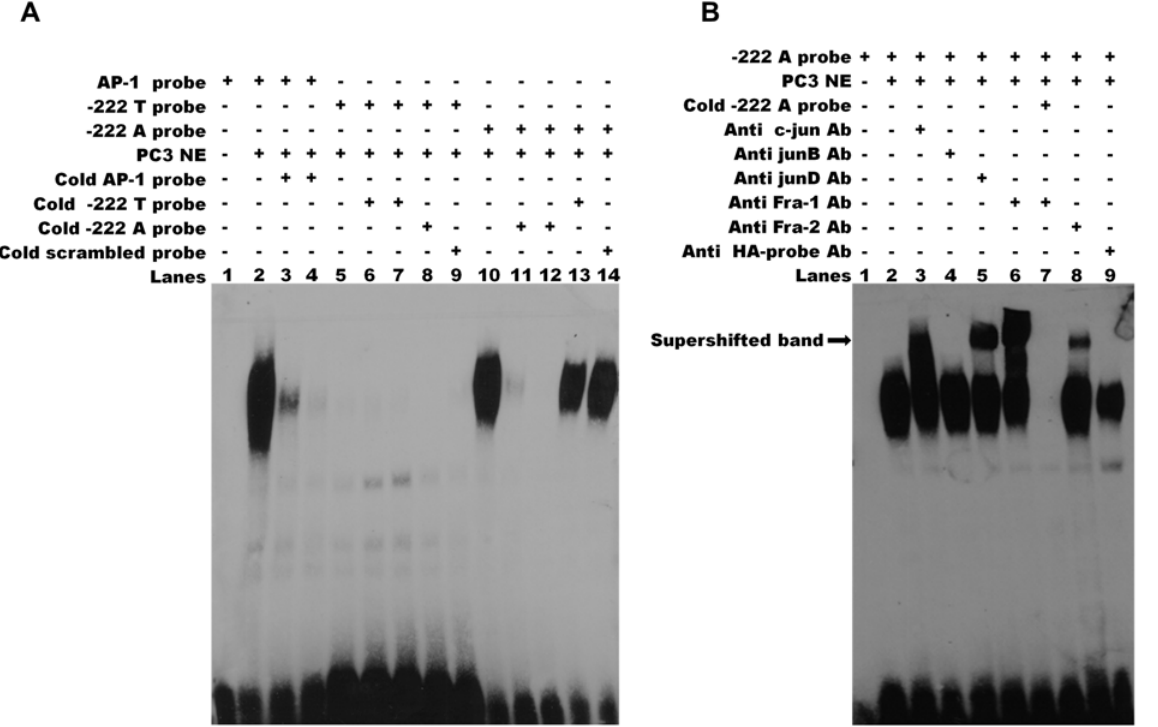
Fig 4. The rs112481213 variant alter the AP-1 binding site. (A) Electrophoretic mobility shift assay (EMSA) for AP-1 binding in nuclear extracts (NEs) of PC-3 cell line. The binding activities of NEs (lanes 2 – 14) were analyzed by EMSA using biotin-labeled AP-1 probe (lanes 2 – 4), -222 T probe (lanes 5 – 9) and- 222 A probe (lanes 10 – 14). Competition was performed with 50 and 200 fold molar excess of the cold probe (lanes 3 – 4, 6 – 7, 11 – 12). Cross competition was performed using the cold probe carrying the alternative allele (lane 8 and 13) and the cold scrambled probe (lane 9 and lane 14) at 200 fold molar excess. No binding was detectable for-222 T probe (lanes 5 – 9). The DNA-protein complex of-222 A probe (lane 10) can be eliminated by 50 or 200 fold molar excess of cold-222 A probe (lanes 11, 12) but not by 200 fold molar excess of cold-222 T probe and cold scrambled probe. (B) Specificity of AP-1 binding activity. Supershift assay was carried out for-222 A probe using specific antibodies for the AP-1 components c-Jun (lane 3), JunB (lane 4), JunD (lane 5), Fra-1 (lane 6) and Fra-2 (lane 8). A supershifted DNA-protein-antibody complex (indicated by the arrow) is observed (lanes 3, 5, 6, 8). Lane 7 shows that the specific complexes were eliminated by addition of 200 fold molar excess of cold-222 A probe. No supershifted complex was observed adding HA-probe antibody used as negative control (lane 9). The results are representative of three independent